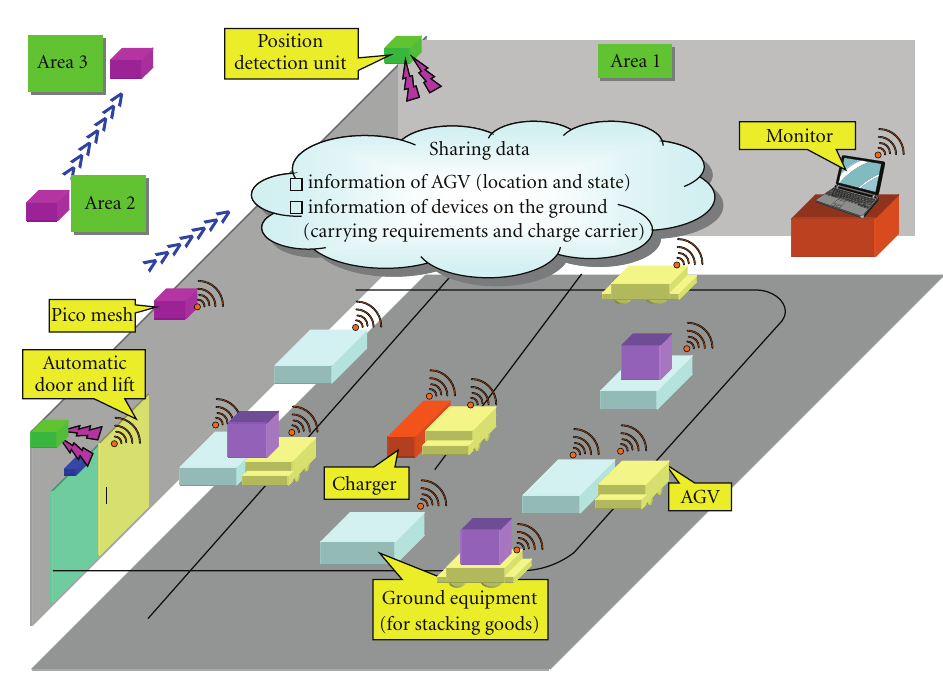
Figure 2: AGV system